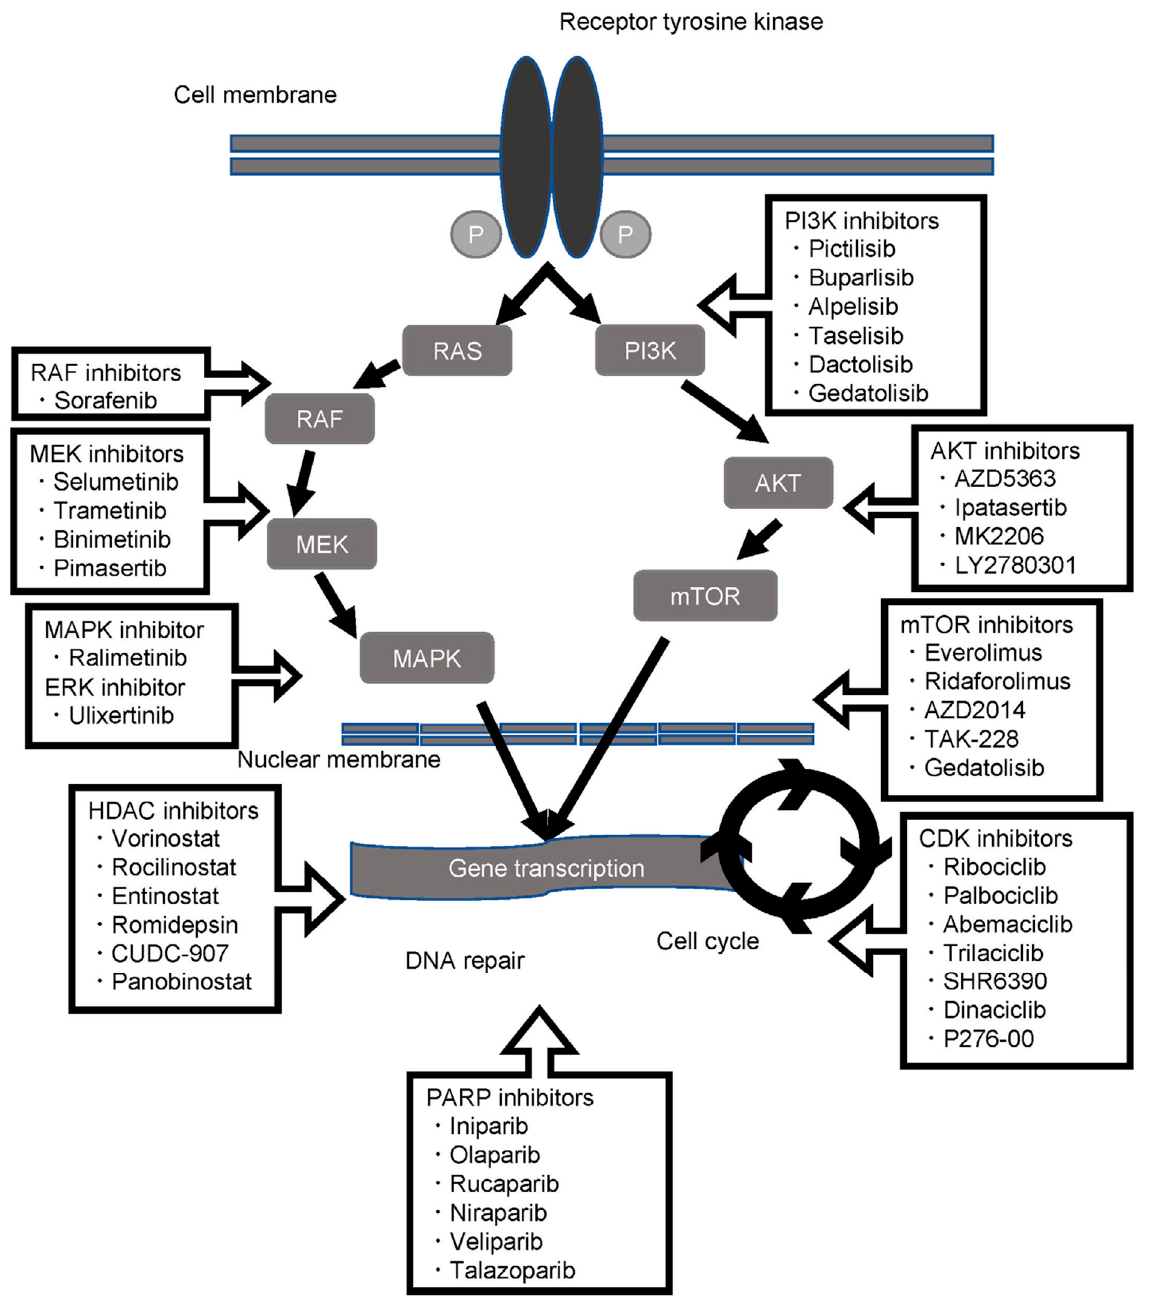
Figure 4. Different molecular pathways and potential targets for breast cancer therapy. Adapted from ref. [1].